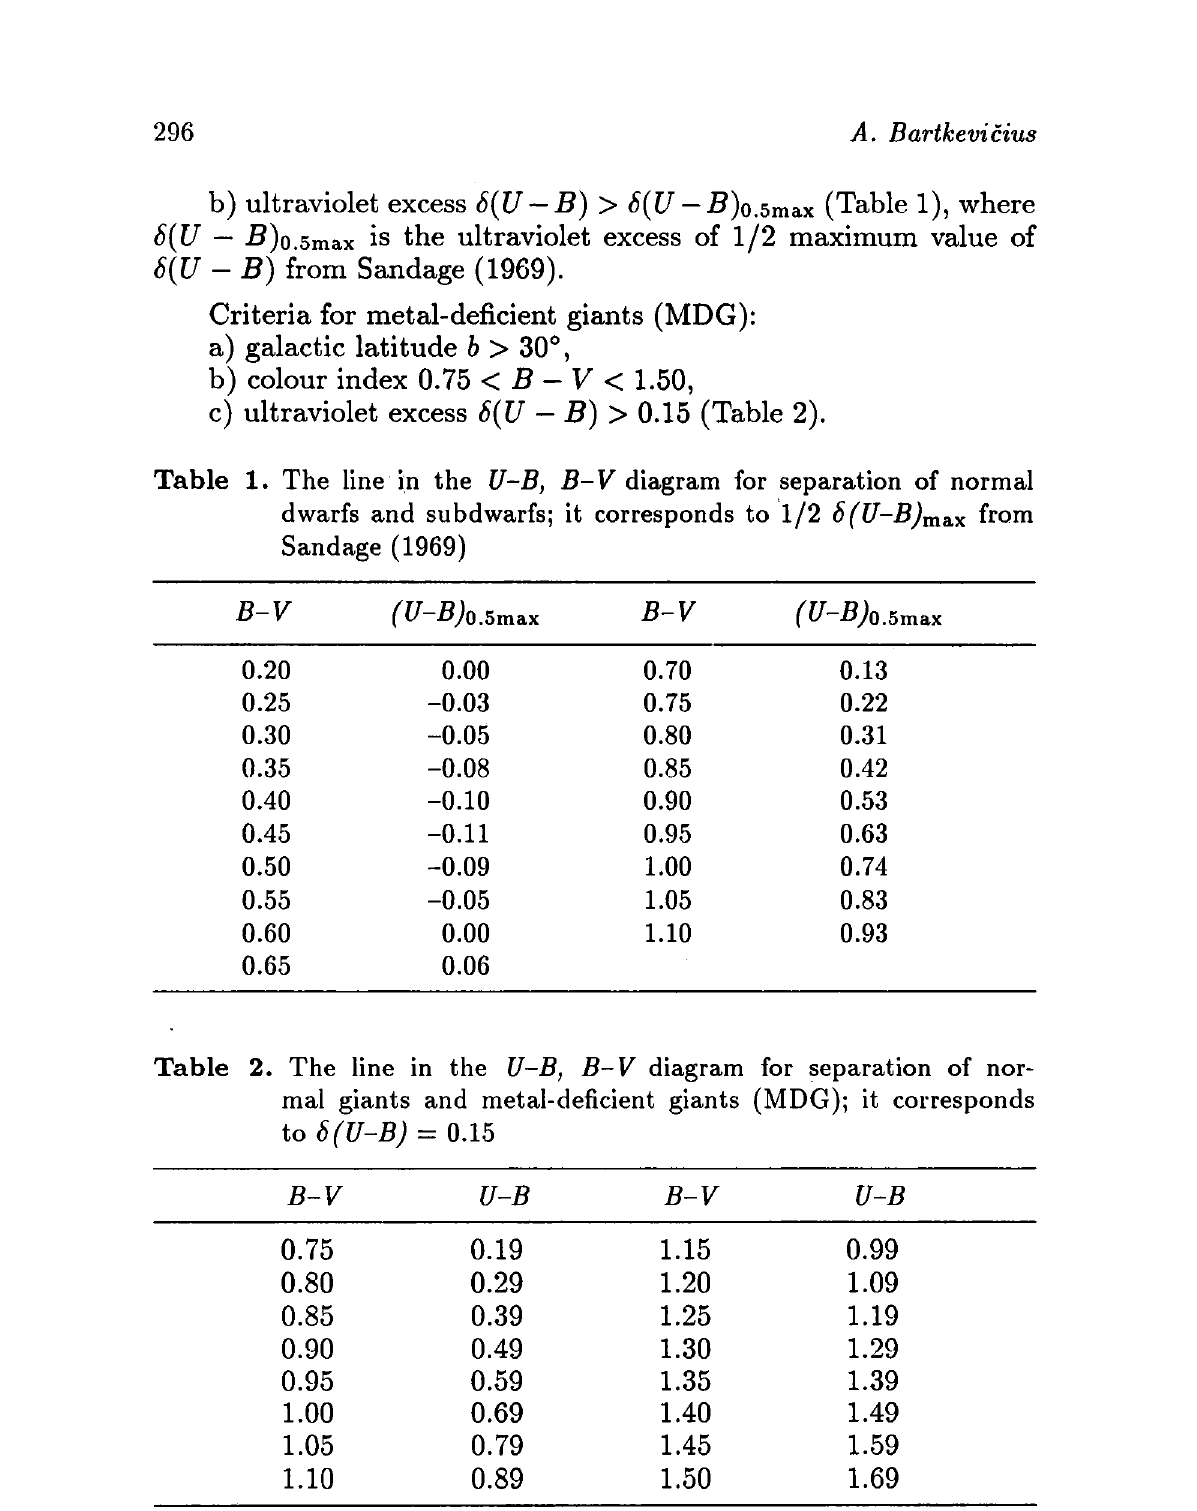
Table 1. The line in the U-B, Β-V diagram for separation of normal dwarfs and subdwarfs; it corresponds to 1/2 S(U-B)